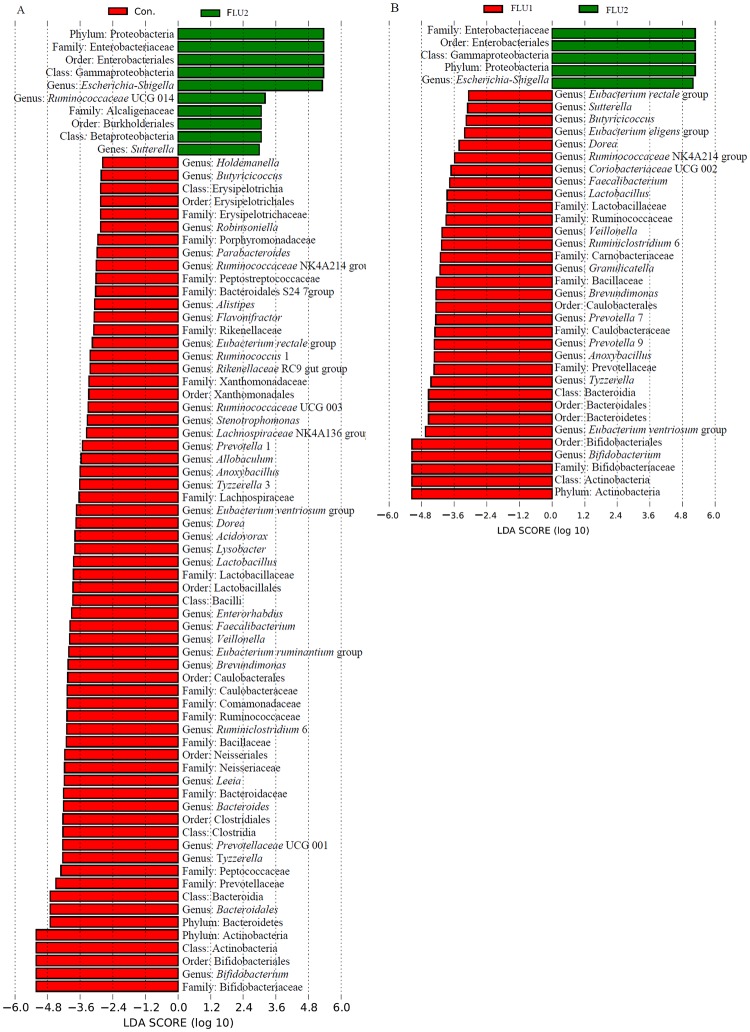
Analysis of the different abundant bacterial taxa using LEfSe.The bacterial percentage of the fermented samples was used for LEfSe analysis. The P-value <0.05 was identified as being significantly different between groups. Significantly enriched bacterial phyla, classes, orders, families, and genera are listed next to the histogram. Con, FLU1, and FLU2 represent samples collected after cultured using VI media with DMSO, 20 μM, and colon concentration of FLU. A Significantly different bacteria between FLU1 and FLU2. B Significantly different bacteria between groups of FLU2 and DMSO.